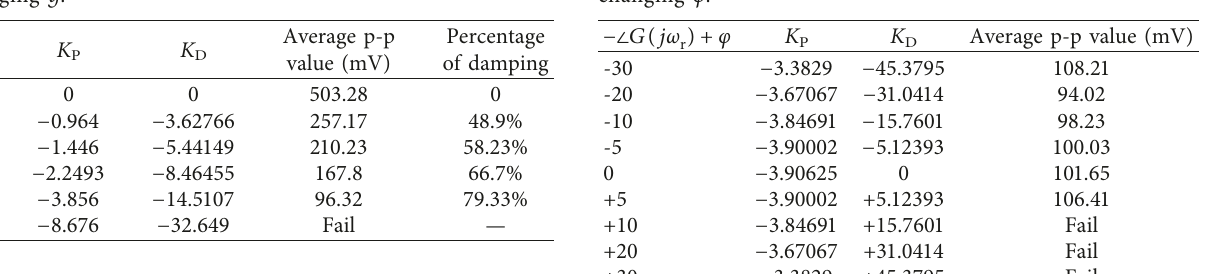
Figure 6: (a) The composition of the active vibration control system: (b) wiring diagram of the active vibration control system and (c) the figure of the cantilever sting with piezoelectric stacks. Table 1: Comparison of vibration damping results with changing g .